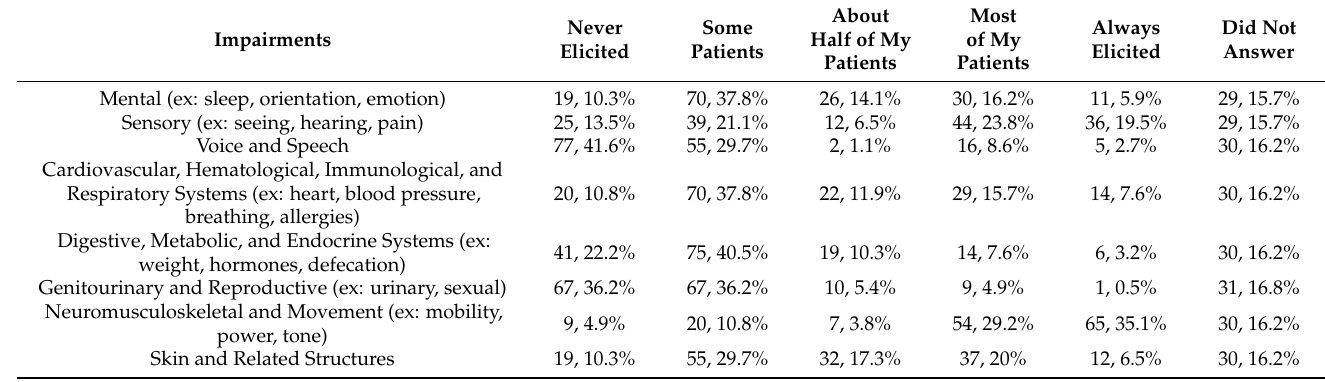
Table 5. Participant Report of Screening in Clinical Practice for Impairments of Body Functions ( n , %).